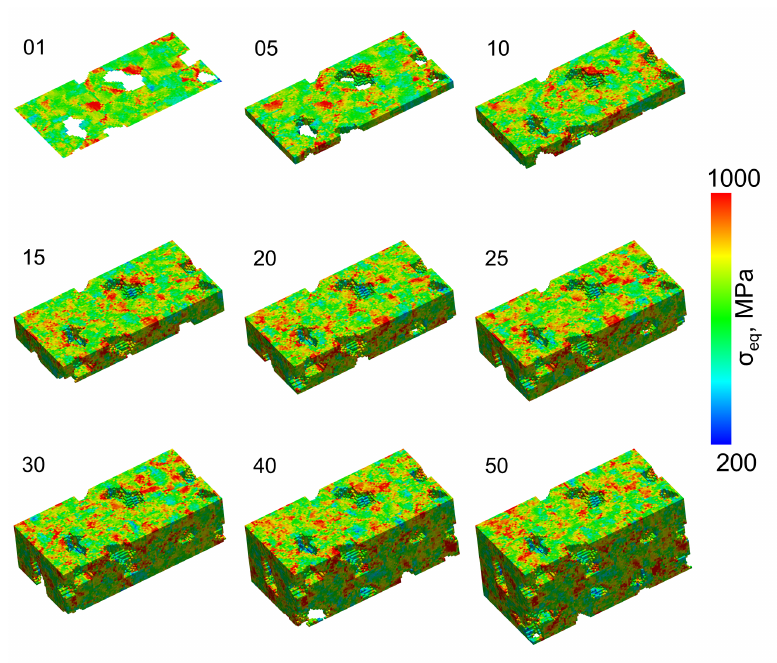
Figure 5. Local von Mises true stress distribution—in ferrite phase—for all geometries of RVE-E at 25% of global true